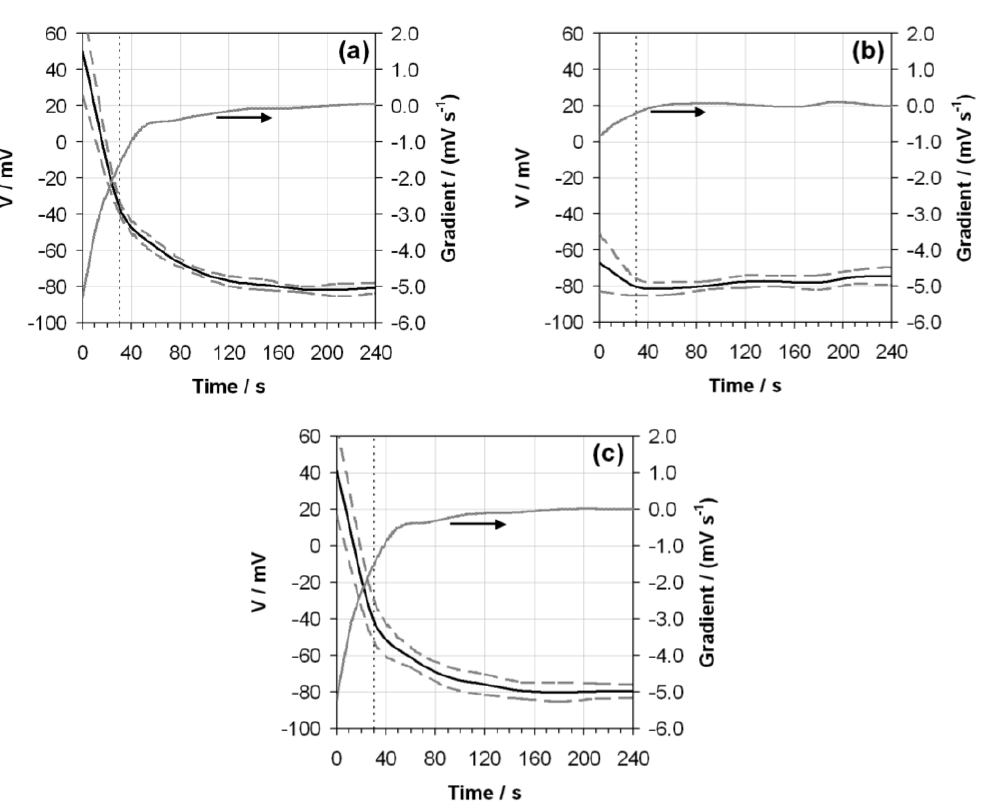
of this measurement set (dashed grey line) and the gradient of the average voltage response (grey line, right-hand axis) are also shown. The ASTM D6423 specified measurement time is indicated (vertical dotted